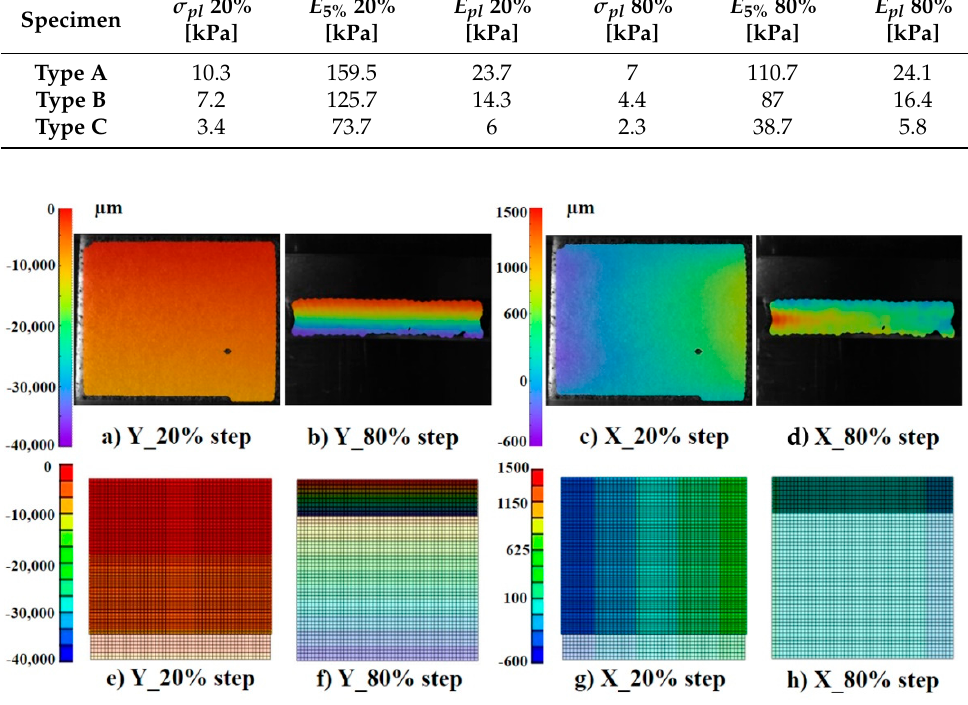
Figure 4. Experimental displacement maps of type B foam along the load, Y diretion, until 20% ( a ) and 80% ( b ) of strain and corresponding results obtained by numerical analysis ( e , f ). Experimental displacement maps of type B foam along the direction transverse to the load, X, until 20% ( c ) and 80% ( d ) of strain and corresponding results obtained by numerical analysis ( g , h ).